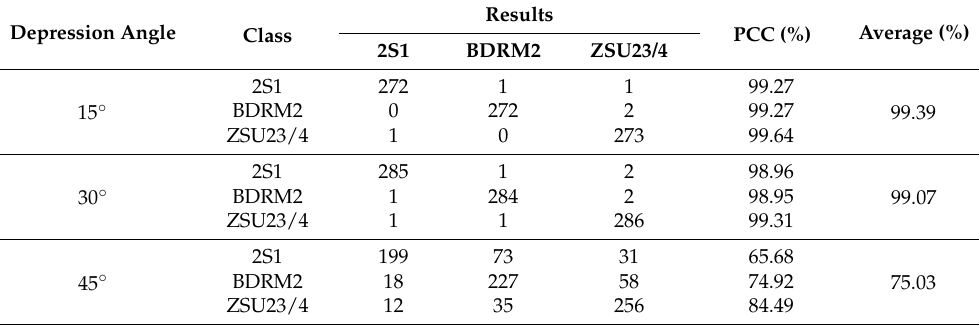
Table 8. Recognition results of the proposed method under depression variance.